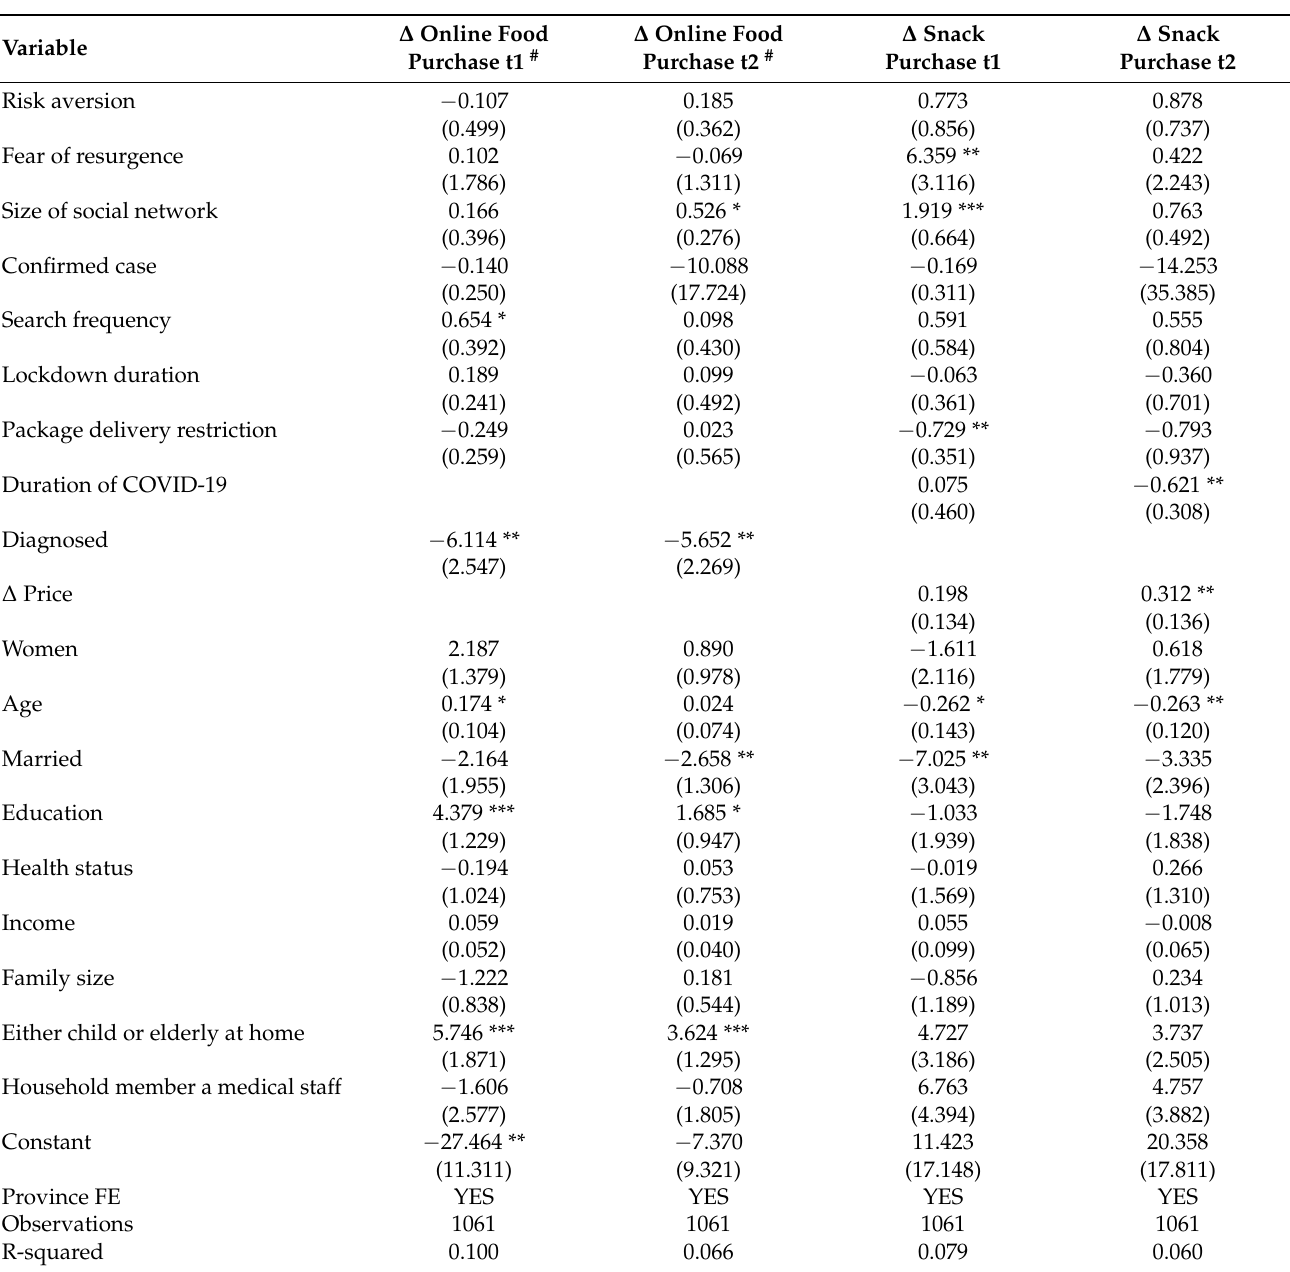
Table 3. Empirical results for food